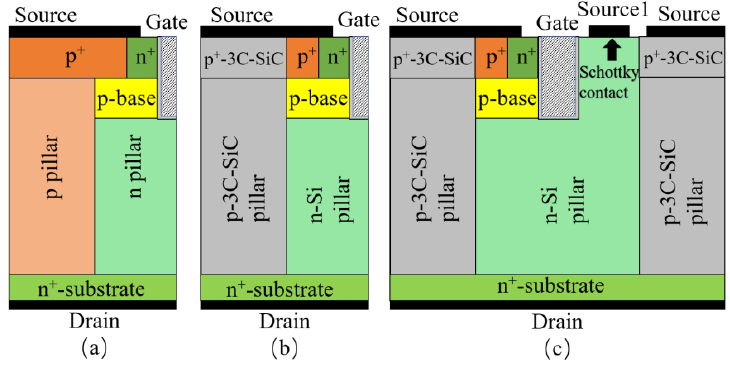
Figure 1. Schematic of ( a ) Si SJ; ( b ) Si/SiC SJ; and ( c ) Si/SiC SJ with SBD.